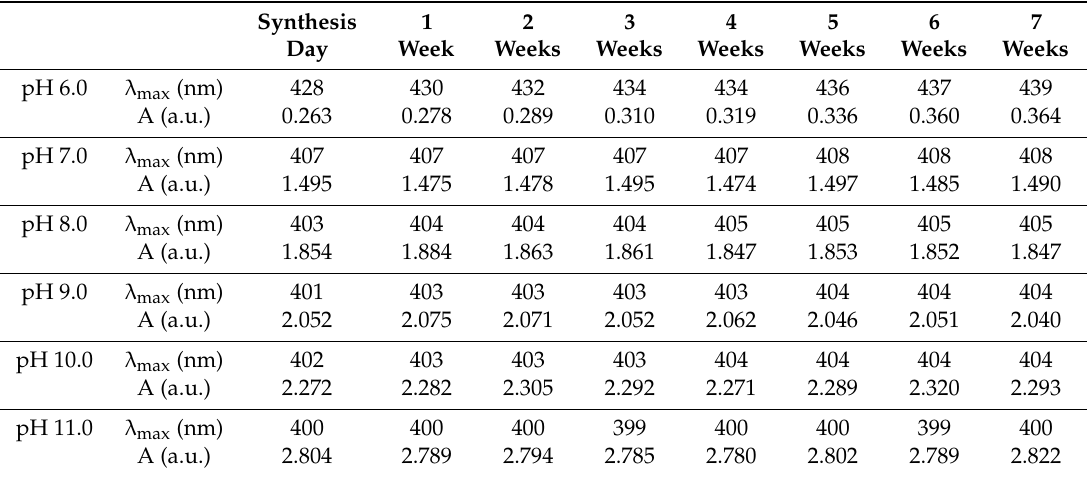
Table 1. Comparison of data on the stability study of colloids reduced by citric acid determined using a UV-Vis spectrometer.